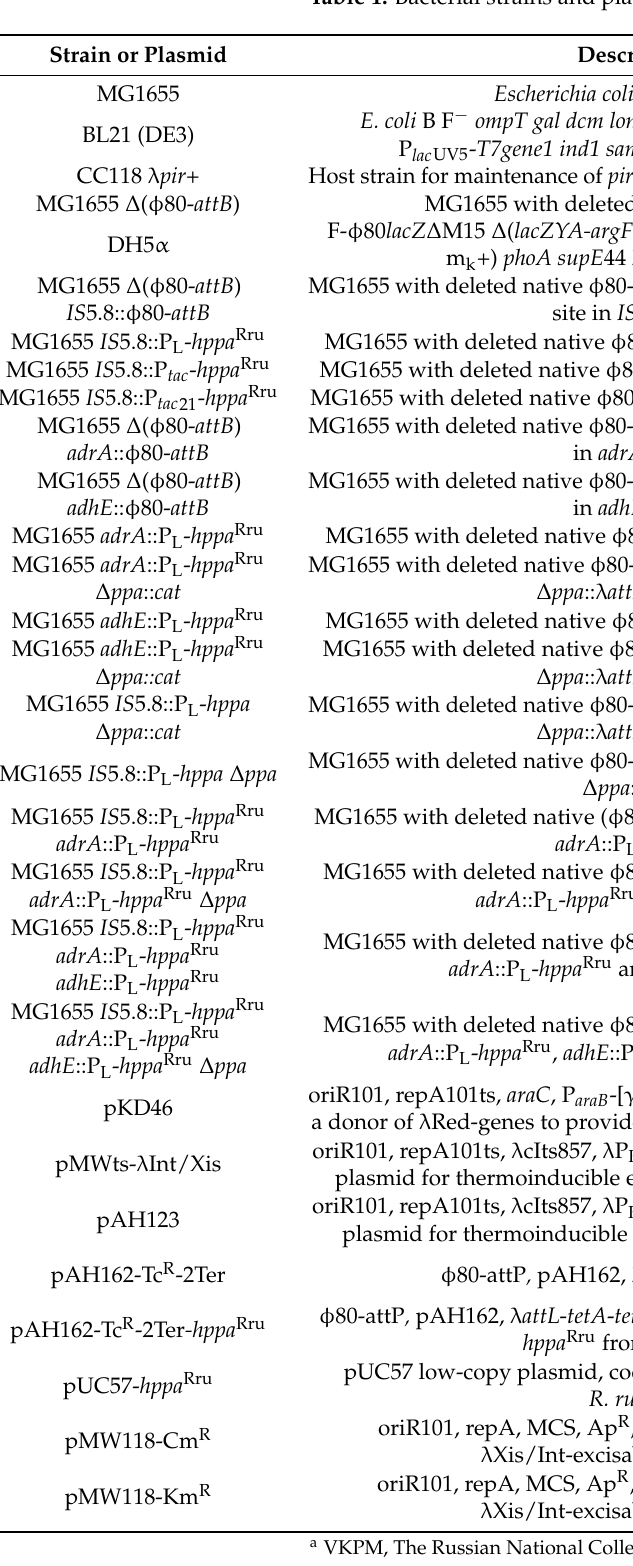
Table 1. Bacterial strains and plasmids used in this